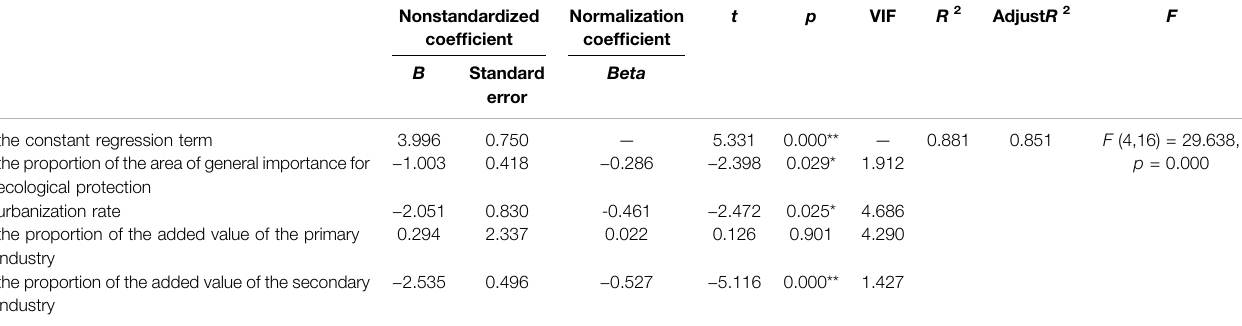
TABLE 4 | Multiple Linear Regression analysis